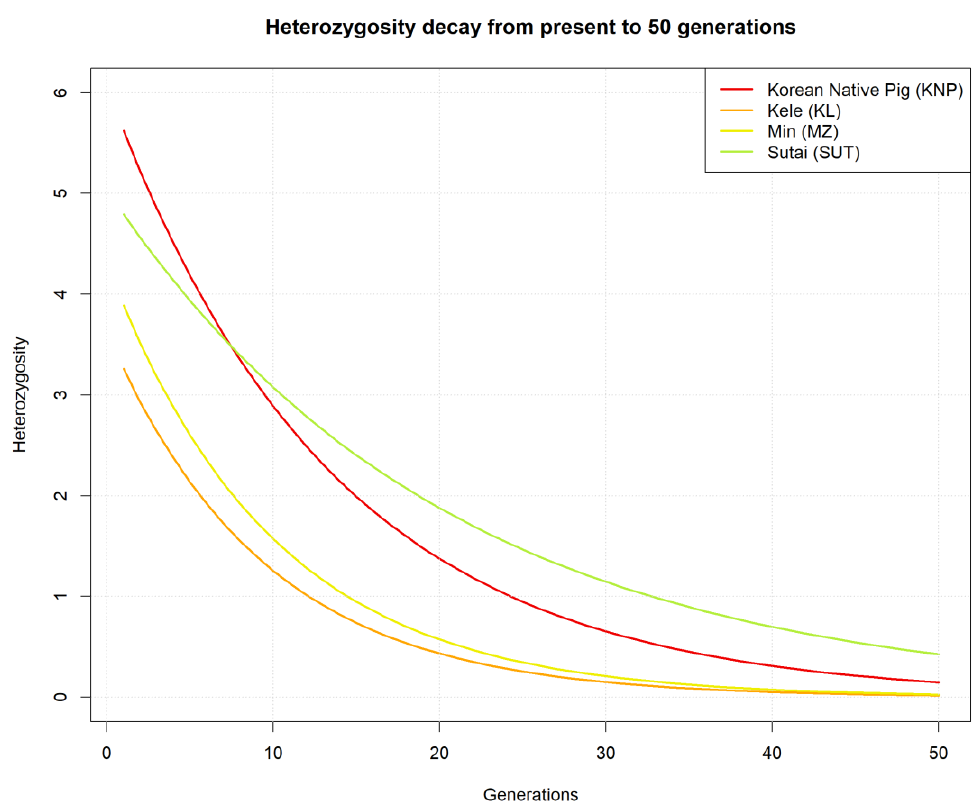
Figure 8. Changes in heterozygosity within 50 generations for the KNP, KL, MZ, and SUT breeds.